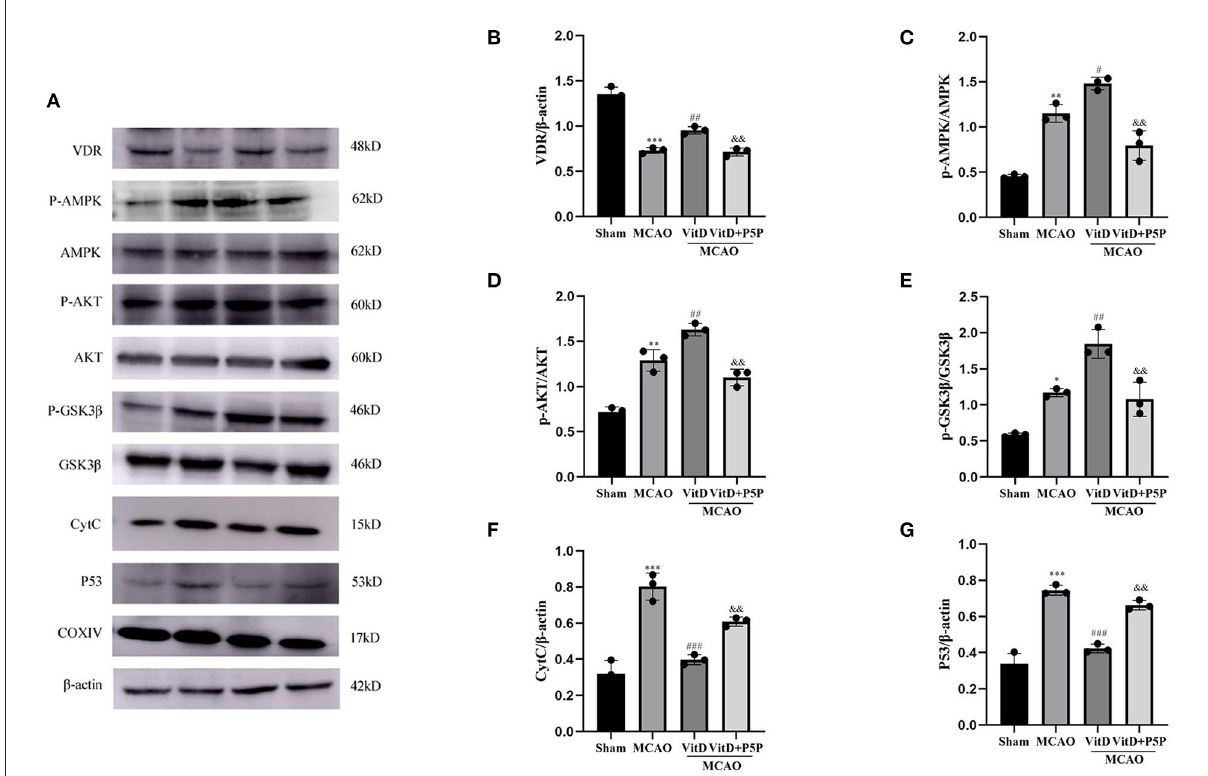
FIGURE4 (A) Images of Western blot for VDR, the AMPK/AKT/GSK-3 β pathway, P53, and CytC. (B–G) The expression levels of CytC, VDR, p-AMPK, p-AKT, p-GSK-3 β , and P53 in the brain tissues of different groups were analyzed using ImageJ. All values are shown as the mean ± SEM. * P < 0.05, ** P < 0.01, *** P < 0.001 (vs. Sham), # P < 0.05, ## P < 0.01, ### P < 0.001 (vs. MCAO), && P < 0.01 (vs. VitD), n = 5. MCAO, middle cerebral artery occlusion; P5P, antagonist of VDR; Vit D,